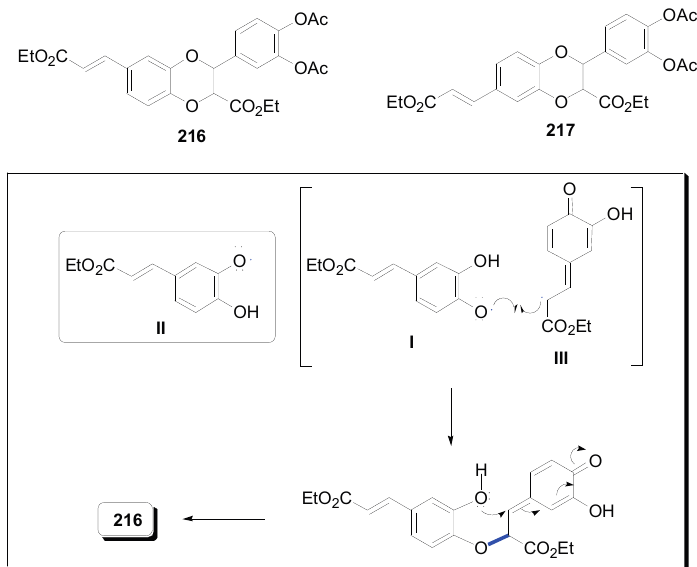
Figure 17. Structure of oxyneolignans 216 and 217 and outline of the mechanism